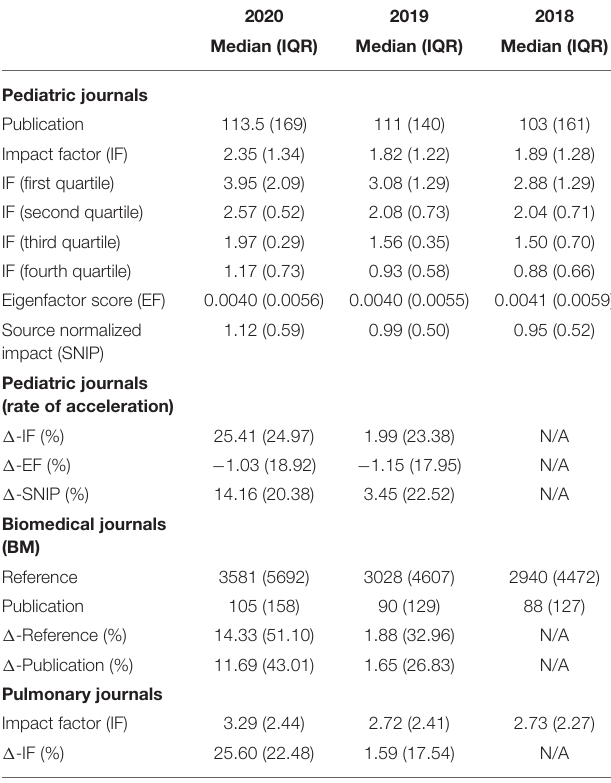
TABLE 1 | The characteristics of bibliometrics of pediatric journals and publication/reference counts in biomedical journals between the